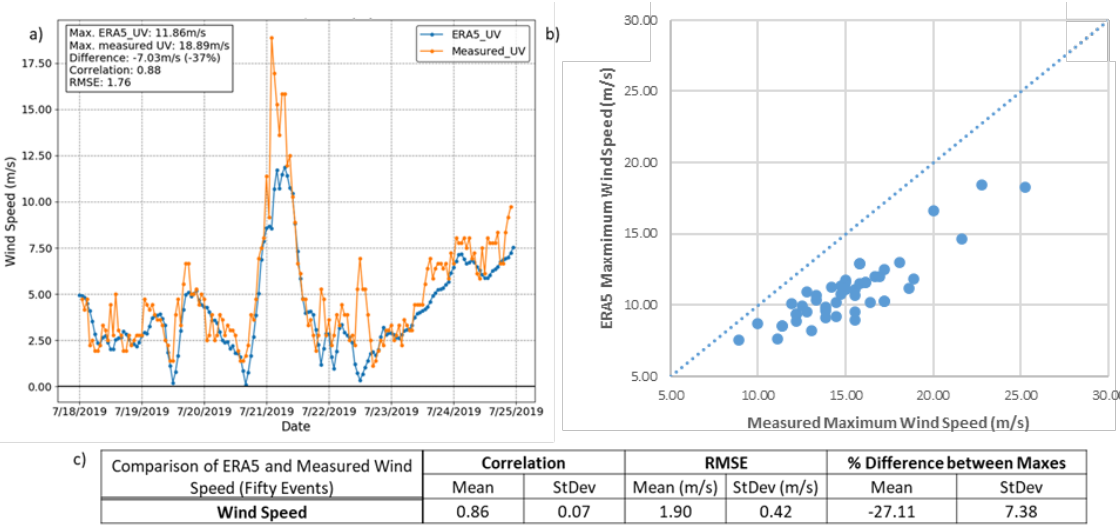
Figure 8. The performance of ERA5’s wind speed reanalysis: ( a ) direct comparison of the surface wind field for the largest simulated surge event (July 2019); ( b ) measured vs. modelled maximum wind speeds for all 50 surge events; ( c ) the mean and standard deviation for the correlation, root-mean-squared error (RMSE), and percent difference between the maximums for all fifty surge events.